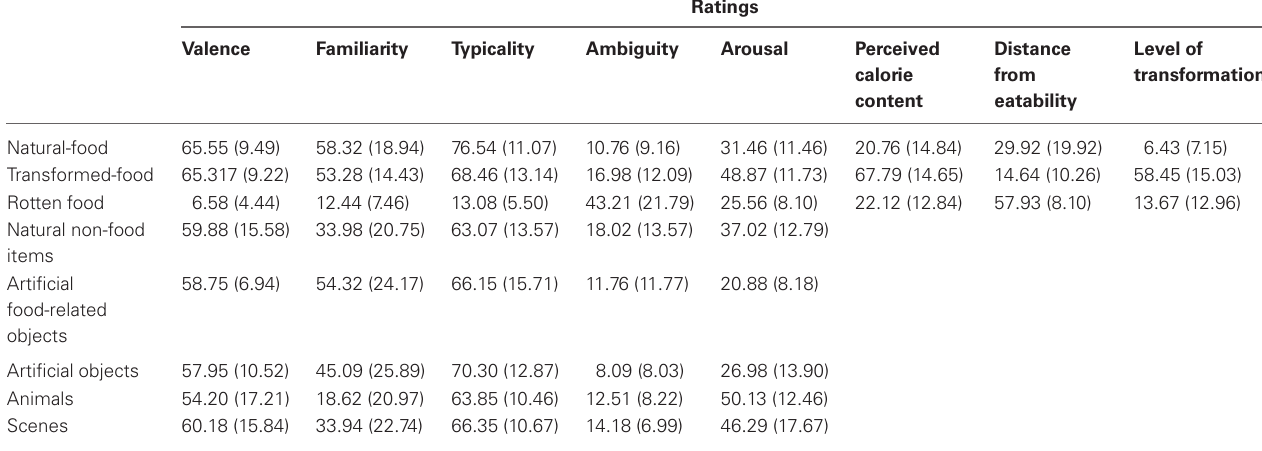
Table 1 | Average ratings aggregated for each food category (standard deviations are in